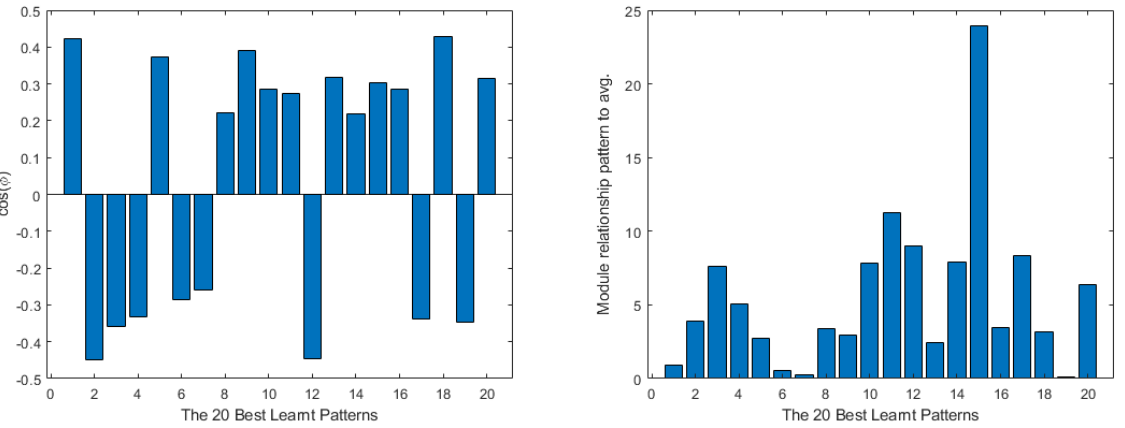
Figure 16. Unified worst learned patterns cos(φ) on the ( left ) and | 𝜕𝐿𝑜𝑠𝑠 | on the ( right ) for the Ackley function using the dynamic alpha and drop-out modifications for 𝜕𝑊 𝑛 Dynamic alpha and Dynamic drop-out mixed together SGD of Ackley function.